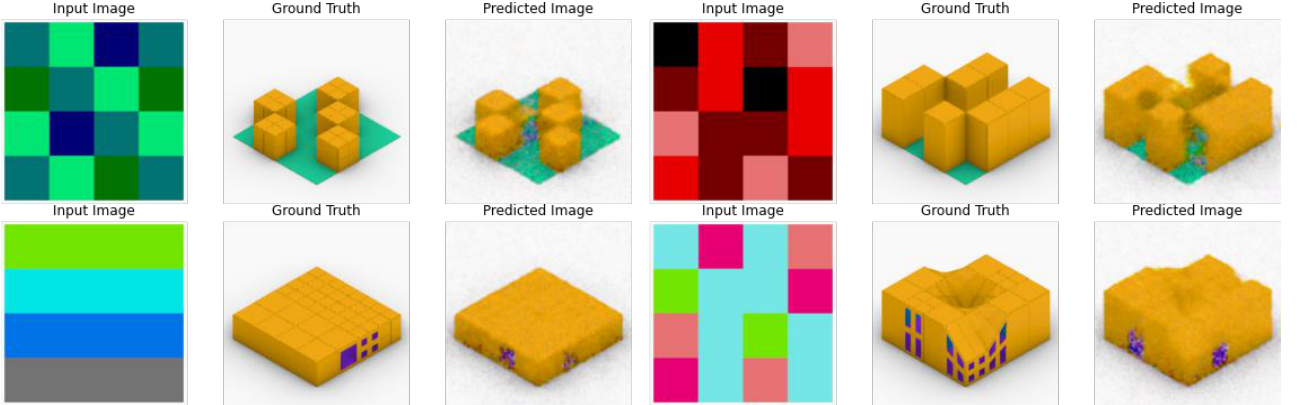
Figure 6. Captures from test B02. The conversion is working and the images are similar but there are mistakes in some parts that evidence that the training has not been enough.